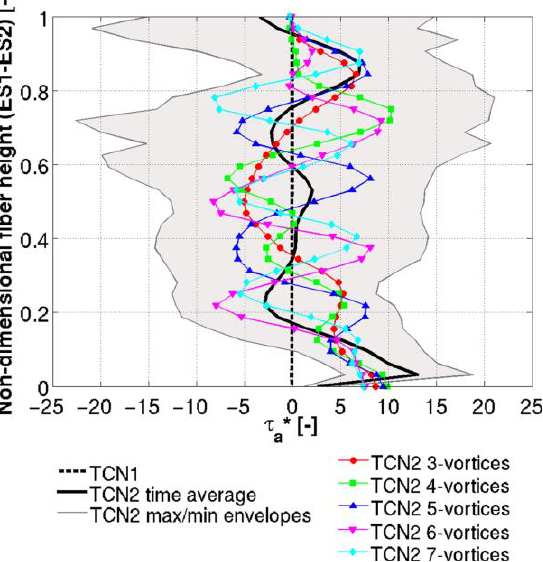
Figure 9. Non-dimensional axial stresses along the fiber. TCN1 and TCN2 cases are compared (including the envelope of minimums/maximums for TCN2). Colored lines are relative to examples of the various configurations encountered during the TCN2 evolution.